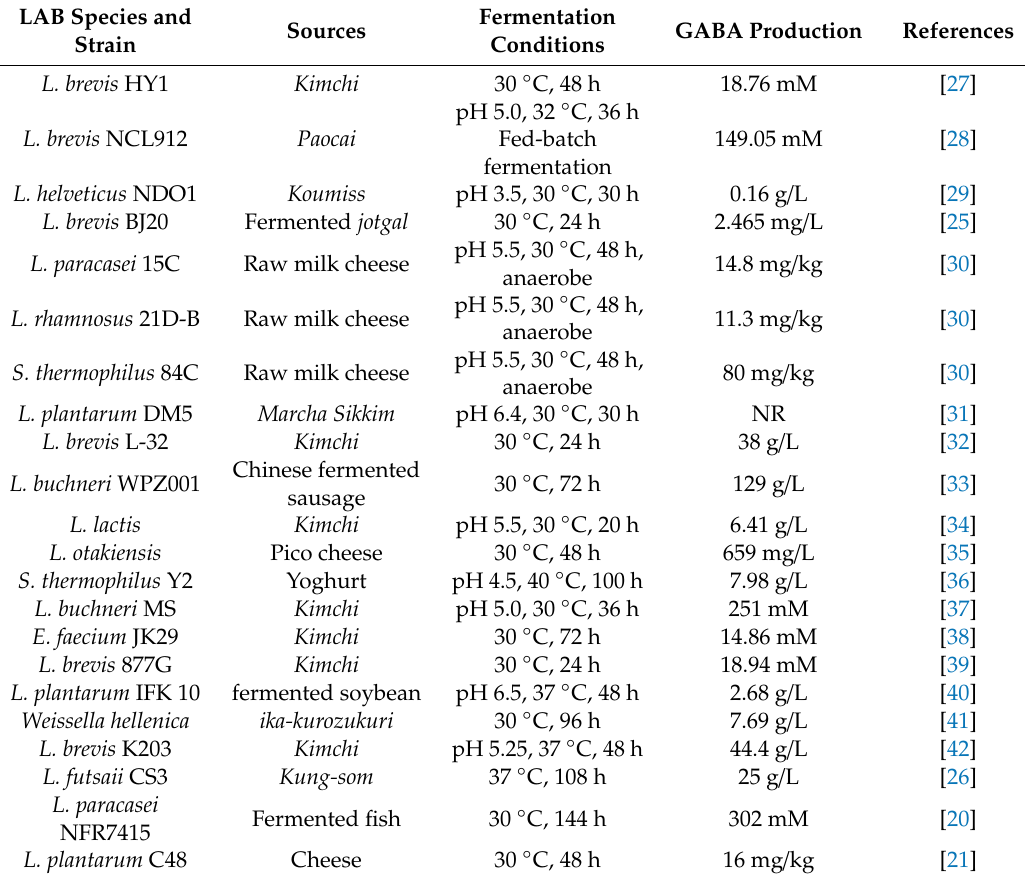
Table 1. Diversity of glutamate to γ -aminobutyric acid (GABA)-converting lactic acid bacteria (LAB), isolation sources, GABA production, and fermentation conditions. GABA concentrations as found in food products fermented with this strain are